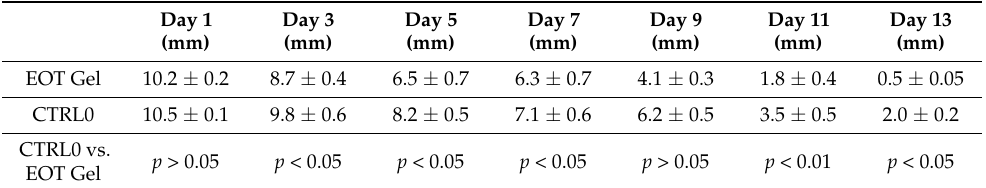
Table 2. Evolution of the induced lesion expressed as the diameter of the lesion measured every 2 days in both groups, along with the statistical interpretation (average value ± SD). The results were considered statistically significant at values of p < 0.05.